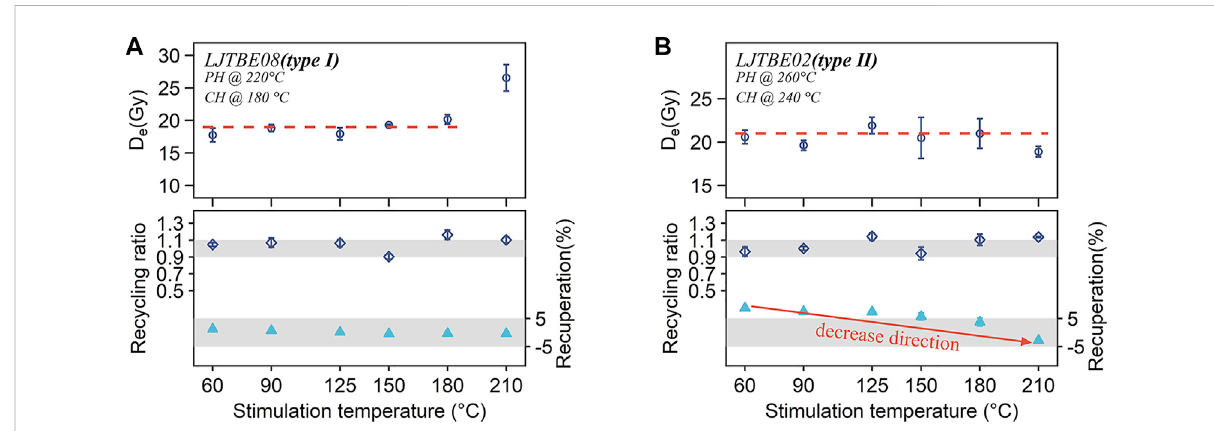
FIGURE 5 (A) D e varies withstimulationtemperaturefor arepresentativeType Isample( LJTBE08 ).Preheatand cut-heattemperaturesare220and 180 ° C, respectively, with stimulation temperatures varying from 60 – 210 ° C. The red dotted line illustrates the range of the plateau. The corresponding recycling ratio and recuperation are also shown. The gray stripes represent the recycling ratio of 0.9 – 1.1 and ±5% recuperation. (B) D e varies with stimulation temperature for a representative Type II sample ( LJTBE02 ). The PH and CH temperatures are 260 and 240 ° C, respectively. The red arrow represents the trend of decreasing